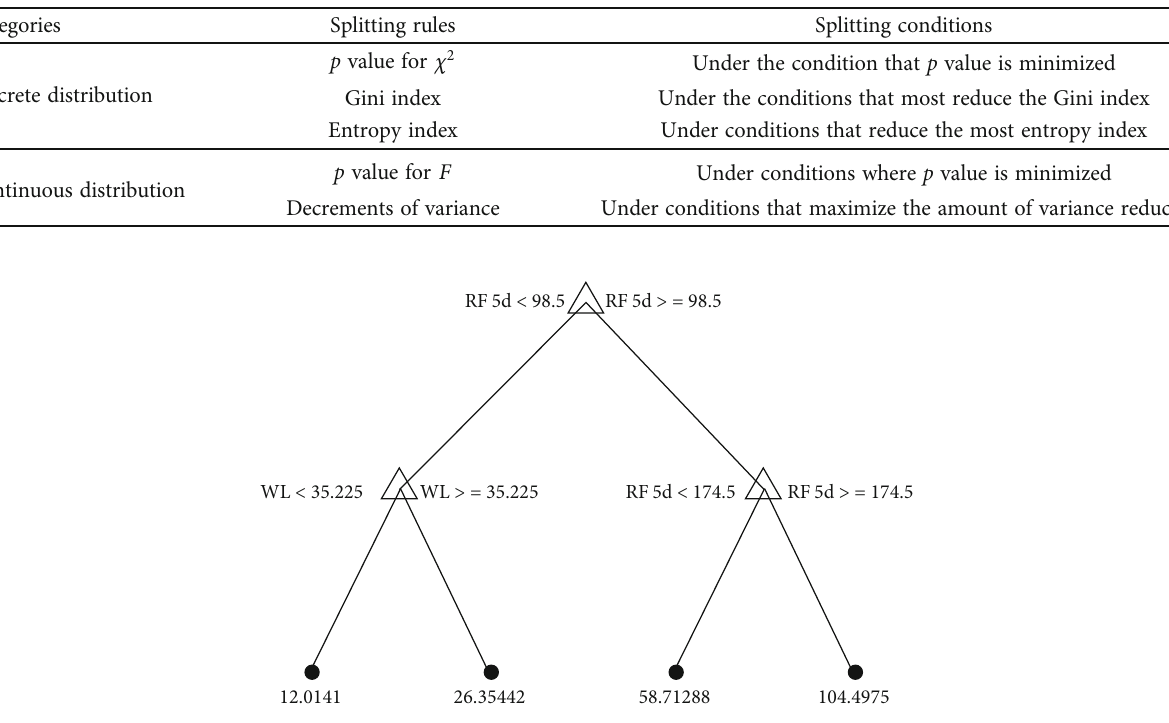
Figure 12: CART algorithm. Table 3: Splitting rules for decision trees.